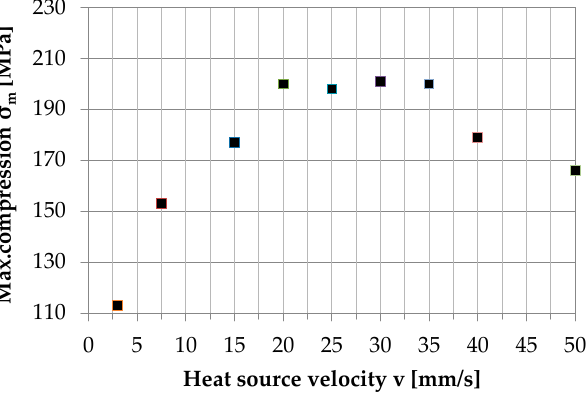
Figure 30. Comparison of the average of the maximum compressive stresses of all the elements of the tool surface under the bead at different heat source velocities.